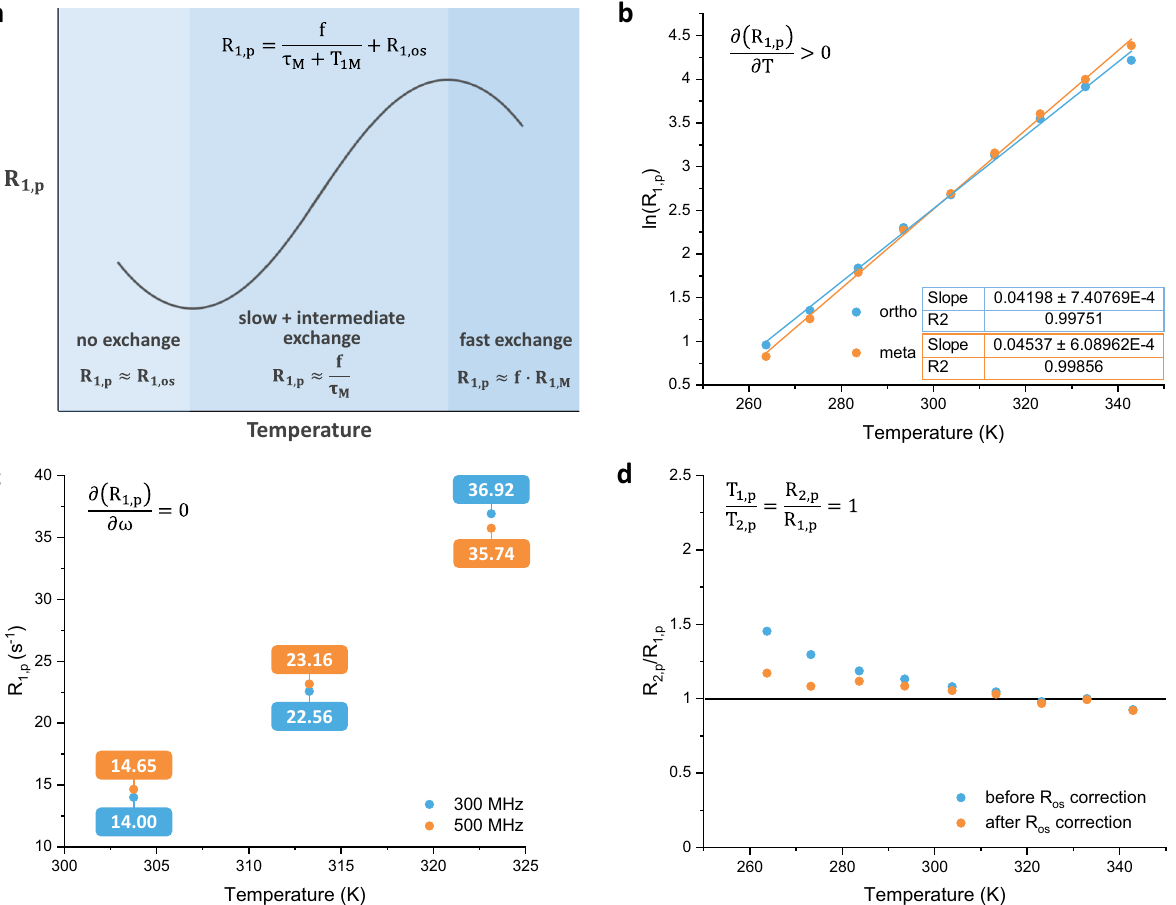
Fig. 4 Determination of relaxation rates of the Mn1/V1 system. a Schematic indication of the different dominating factors governing exchange at different temperatures (low T is left, high T is right). At low temperatures where there is no exchange, the outer-sphere interactions are dominating; at higher temperatures the slow and intermediate exchange regime holds, and the exchange is dominating; and in the fast exchange regime the inner-sphere interactions dominate. The various regimes are indicated in three shades of blue. b Graph of ln( R 1,p ) against the temperature, displaying a positive slope with increasing temperature. The data points for the ortho protons are shown in blue and those for the meta protons in orange. c R 1,p values plotted against temperature comparing 300 MHz (blue dots and blue numbers) and 500 MHz (orange dots and orange numbers) experiments. d Ratio of R 2,p and R 1,p plotted against temperature before (blue dots) and after (orange dots) R 1,os and R 2,os correction. Solvent chloroform- d : acetonitrile- d 3 , 1:1 (v/v).